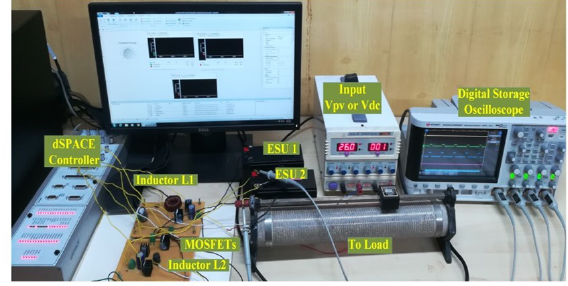
Fig. 5. Experimental setup of FPB 3